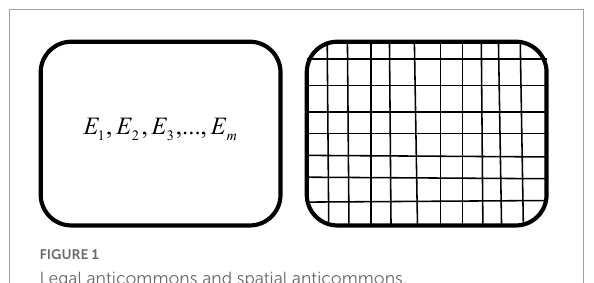
FIGURE1 Legal anticommons and spatial